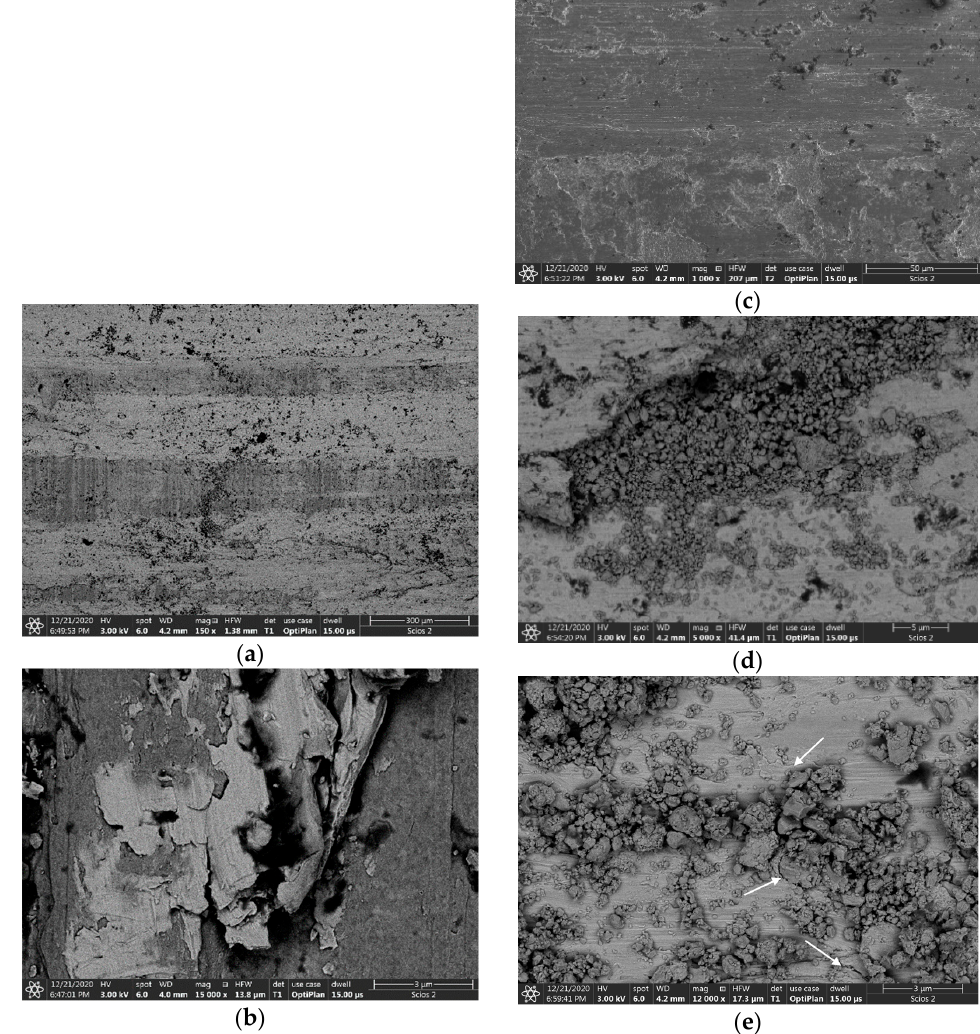
Figure 11. The topography of the wear tracks of nitrided alloy BT22: ( a ) flat wear surface of nitride specimen; ( b ) signs of surface brittle fracture; ( c ) minor metal outflows in lower part of the image; ( d ) fine wear particles; ( e ) wear particles and minor metal outflows (arrowed).